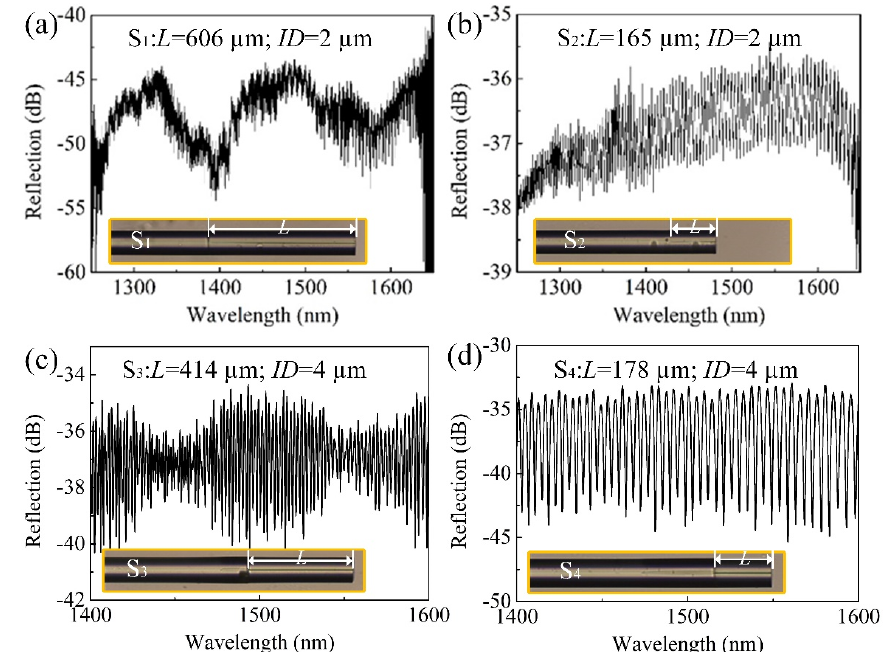
Figure 2. Reflection spectra of the four prepared FPIs with different HCF parameters: ( a ) inner diameter ( ID ): 2 µm and L : 606 µm, ( b ) ID : 2 µm, and L : 165 µm, ( c ) ID : 4 µm and L : 414 µm and ( d ) ID : 4 µm and L : 178 µm.